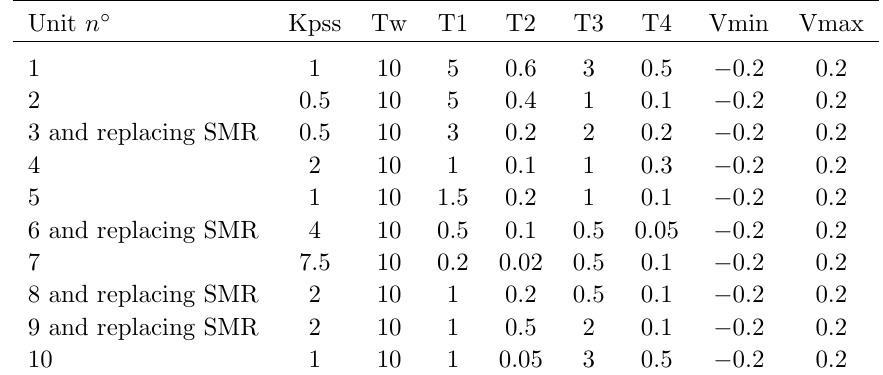
Table A.5. Conventional Power System